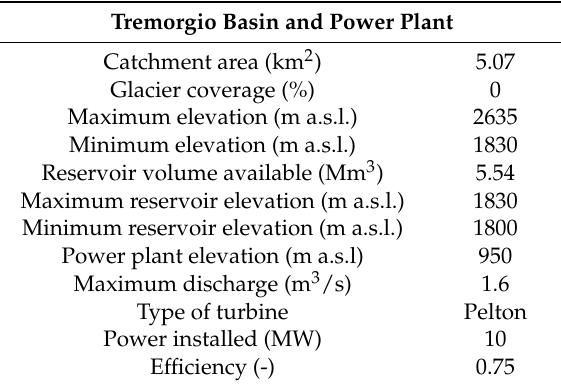
Table 2. Main characteristics of the Tremorgio power plant, reservoir and